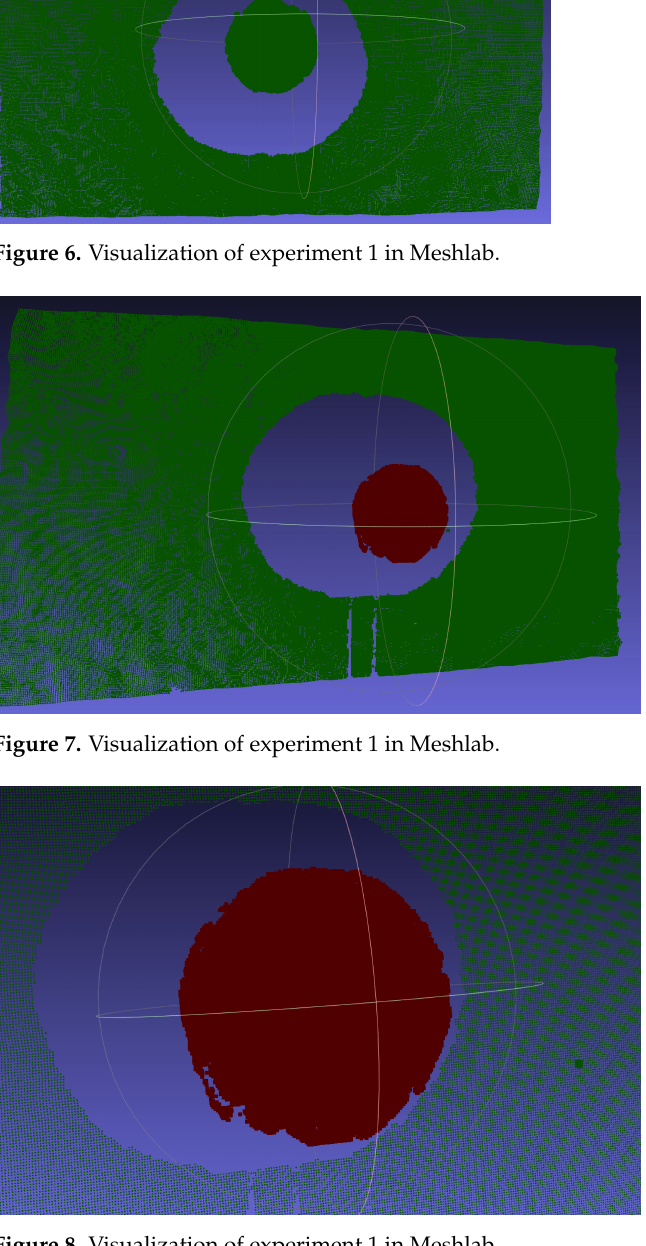
Figure 8. Visualization of experiment 1 in